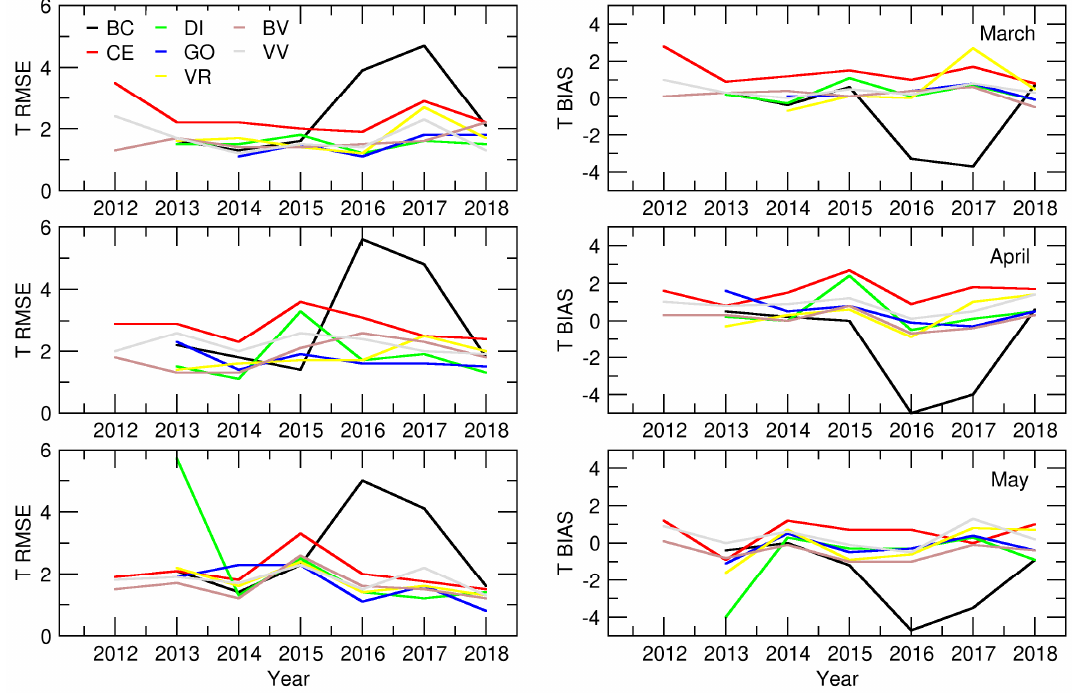
Figure 2. RMSE and BIAS of daily air temperature for selected locations during MAM 2012–2018.